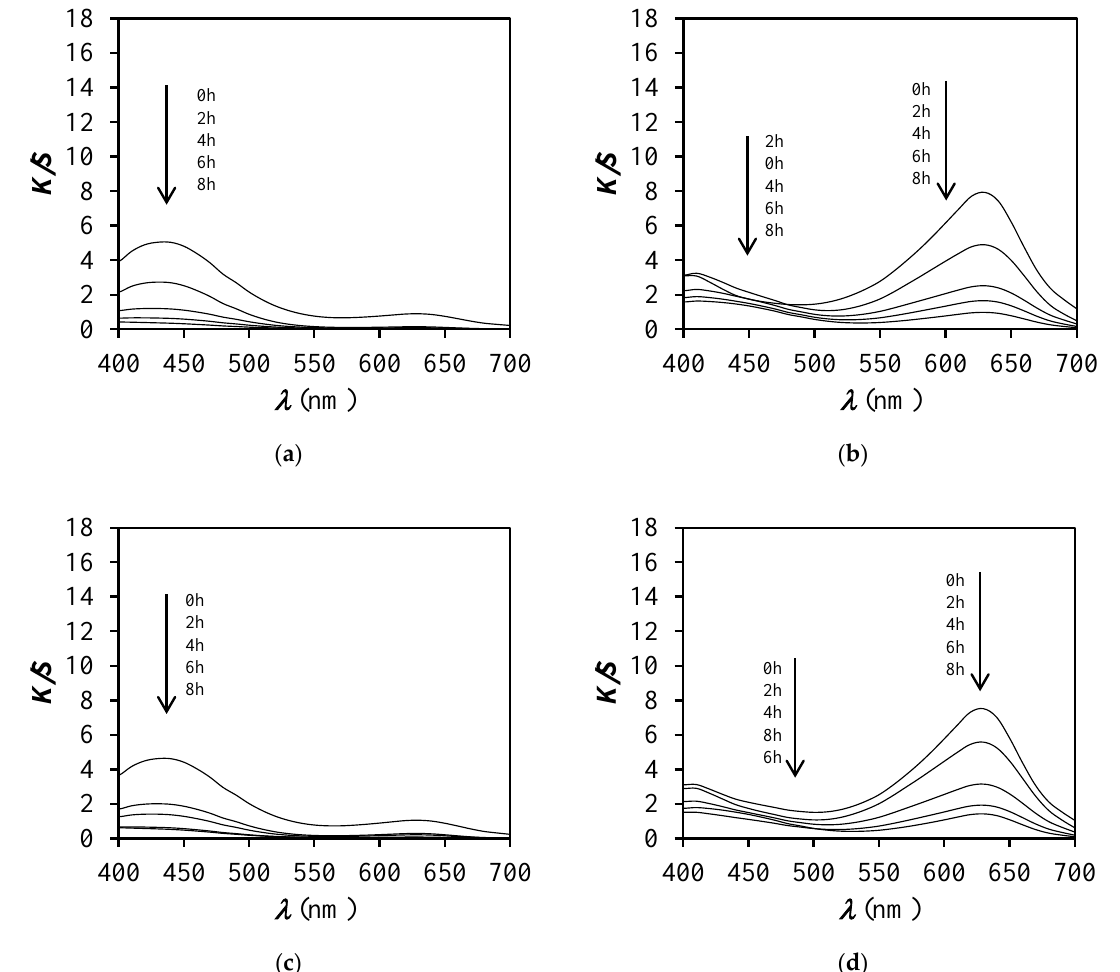
Figure 9. K/S values vs. wavelength ( λ ) for PA_D and PA_DF samples before and after exposure to a Xenotest apparatus for 2, 4, 6, and 8 h and immersion in buffer solutions of pH 3 and 4. ( a ) Sample PA_D at pH 3; ( b ) Sample PA_ DF at pH 3; ( c ) Sample PA_D at pH 4; ( d ) Sample PA_DF at pH 4.